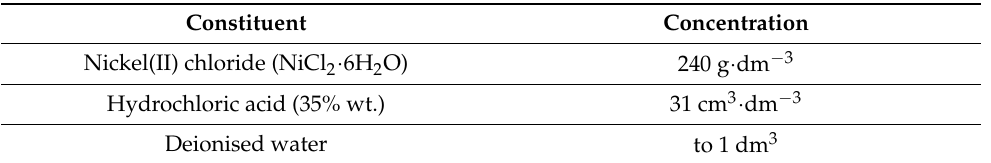
Table 1. The chemical composition of the Ni plating bath. Constituent